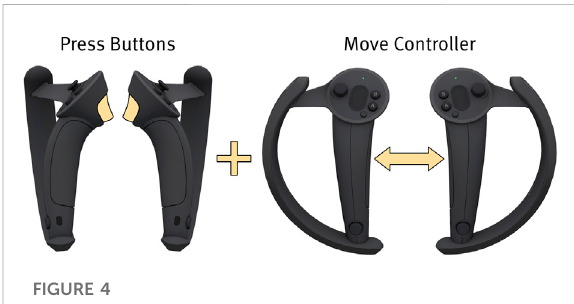
FIGURE 4 Sketch of the body weight modi fi cation interaction through gestures. Participants had to press the trigger buttons on each controller and move the controllers either apart (increase body weight) or together (decrease body weight).